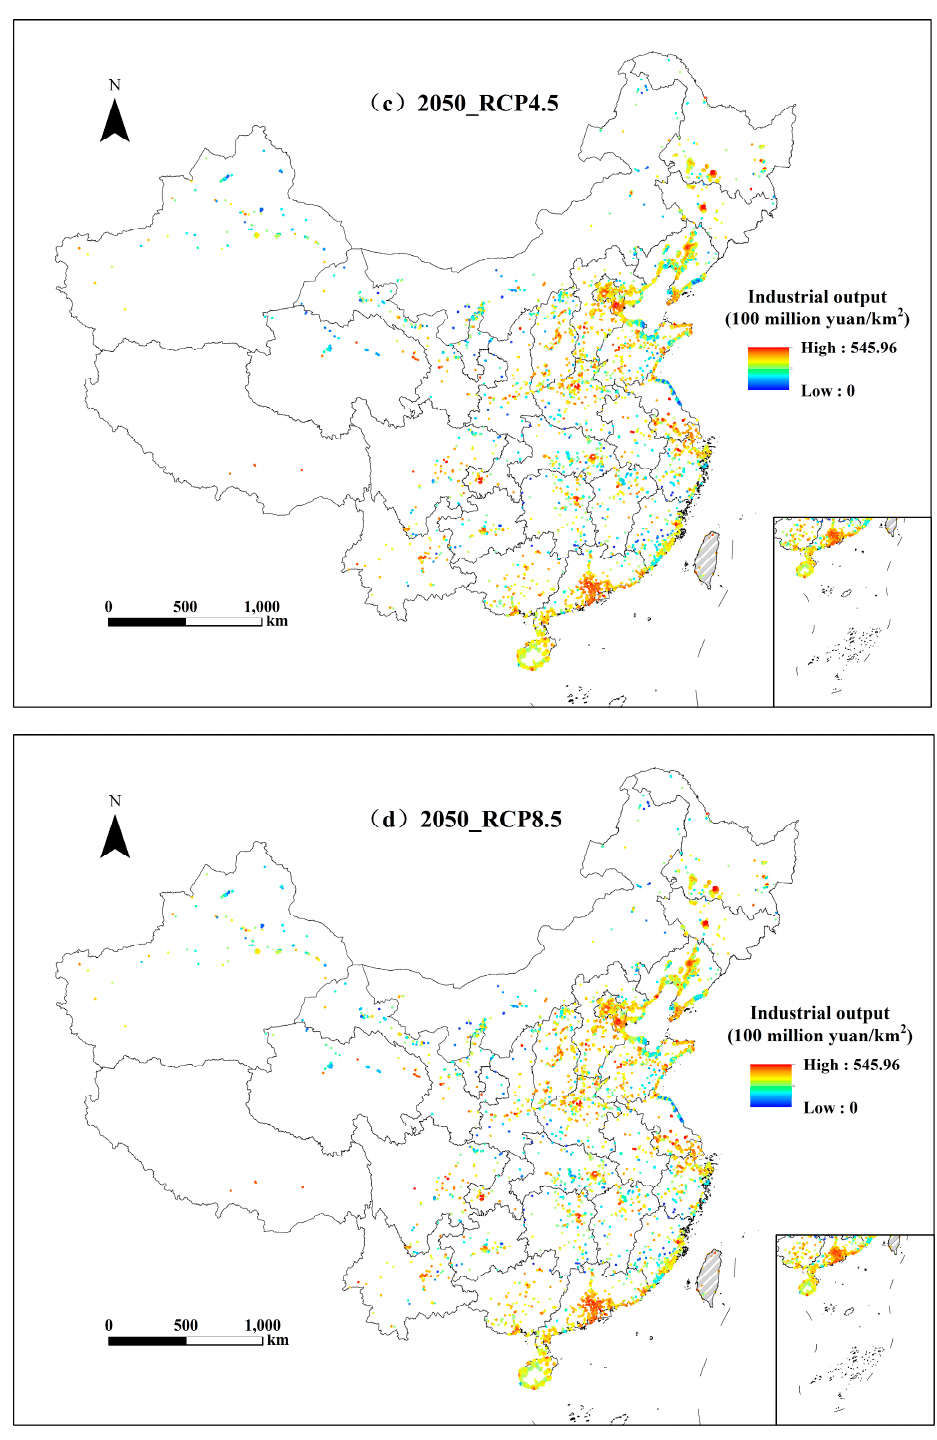
Figure 5. Spatial distribution diagrams of the proportions of China’s industrial output from 2030 to 2050 under scenarios RCP4.5 (( a ) for 2030_RCP4.5 and ( c ) for 2050_RCP4.5) and RCP8.5 (( b ) for 2030_RCP8.5 and ( d ) for